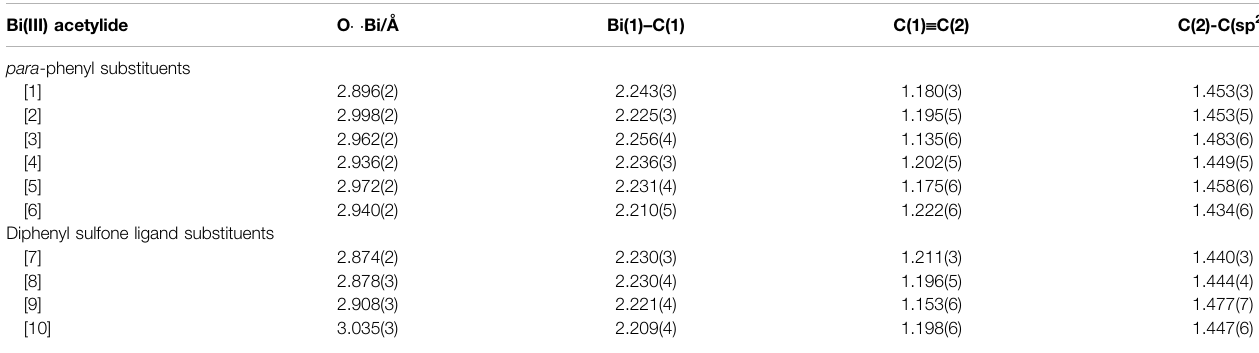
TABLE 1 | Selected bond and transannular Bi(1)-O(1) interaction distances of all synthesized bismuth(III) acetylides. Bi(III) acetylide para -phenyl substituents